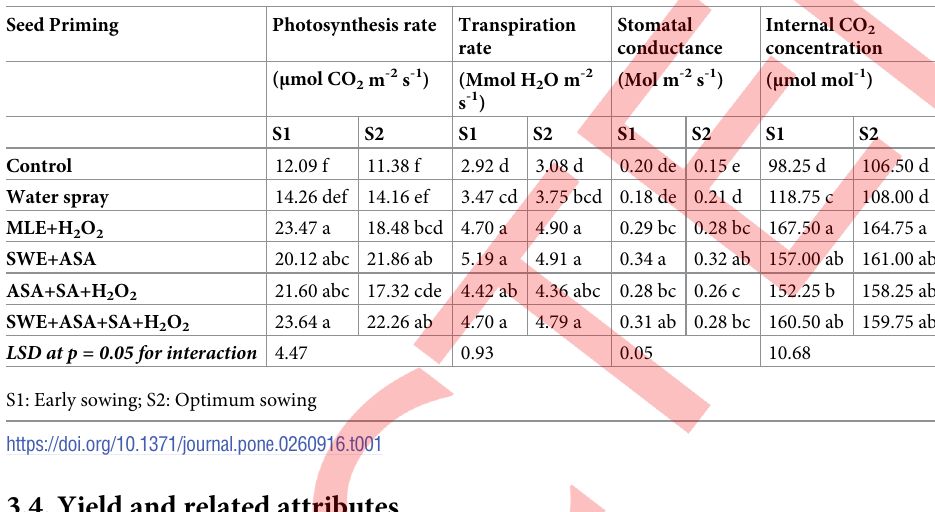
Table 1. Gaseous exchange attributes of maize influenced by foliar applied growth promoting agents and sowing